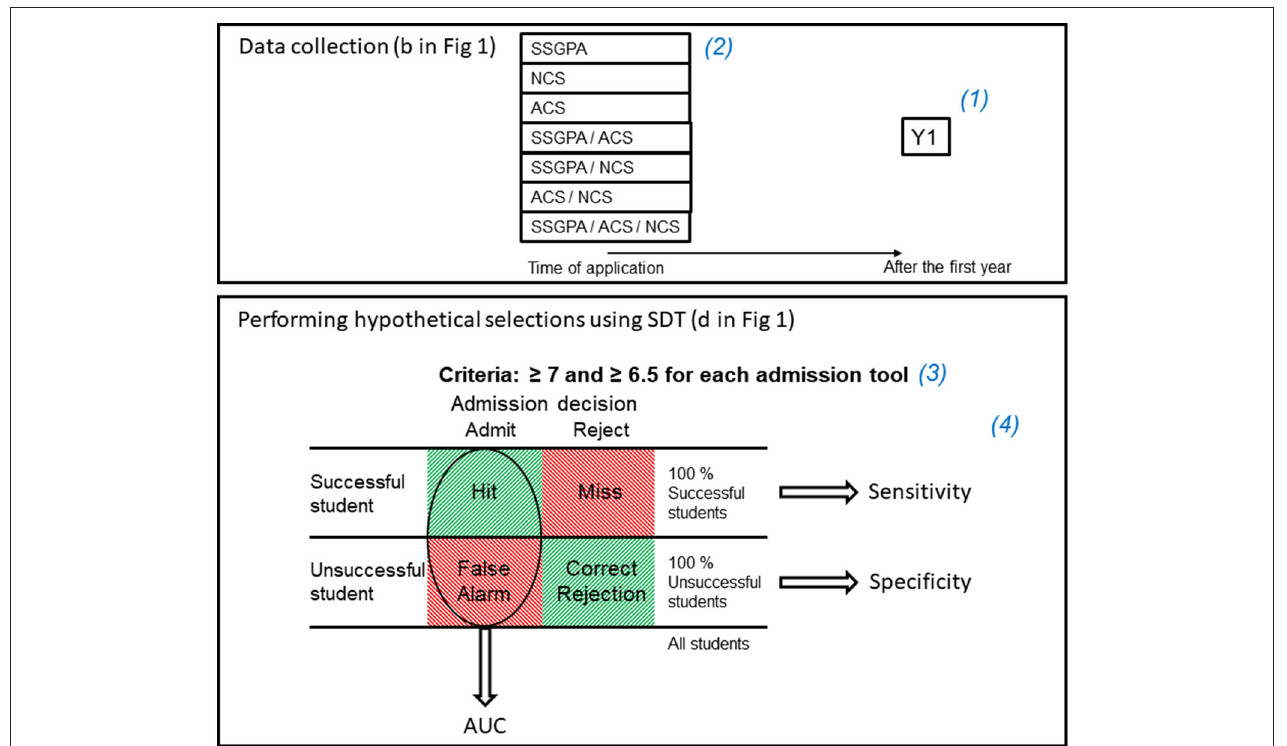
FIGURE 2 | Graphical representation of how we used Signal Detection Theory to investigate validity and reliability of admission instruments by monitoring accuracy of instruments across three cohorts. Successfulness is defined as having passed at least seven of eight first year courses. We used SSGPA, ACS, NCS, and all combinations of those (seven admission tools) as predictors and ≥ 6.5 and ≥ 7 as criteria. The blue numbers in this figure correspond to the blue numbers in Figure 1 . (1) Defining and operationalizing academic success: Y1 = successfulness = having passed at least seven of eight first year courses. (2) Choosing predictors of academic success: SSGPA = secondary school grade point average, ACS = cognitive admission test score, NCS = non-cognitive admission test score. These were the “single” tools. Another three “double” tools were constructed to determine whether students had scored at or above criterion on both-SSGPA-and-ACS-but-not-NCS, both-SSGPA-and-NCS-but-not-ACS and both-ACS-and-NCS-but-not-SSGPA. From the three single admission tools, we constructed “SSGPA/ACS/NCS” which determined whether students scored at or above criterion on all three single predictors (SSGPA and ACS and NCS) and not on only one or two of the three. (3) Choosing which criteria applicants scoring at or above are hypothetically admitted, will be applied: ≥ 6.5 and ≥ 7. (4) Calculating the outcomes of the hypothetical selection. Each individual student was hypothetically classified a hit, miss, false alarm, or correct rejection based on their score on each of the seven admission tools and their academic success. Hypothetical rejection of an unsuccessful student is a correct rejection, hypothetical rejection of successful student is a miss, hypothetical admission of an unsuccessful student is a false alarm and hypothetical admission of a successful student is a hit. AUC = area under the curve (see Figure 3